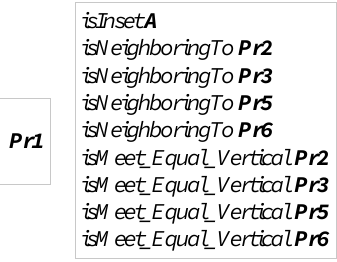
Figure 9. A subset of concepts for the recognition of a cuboid from planar regions.